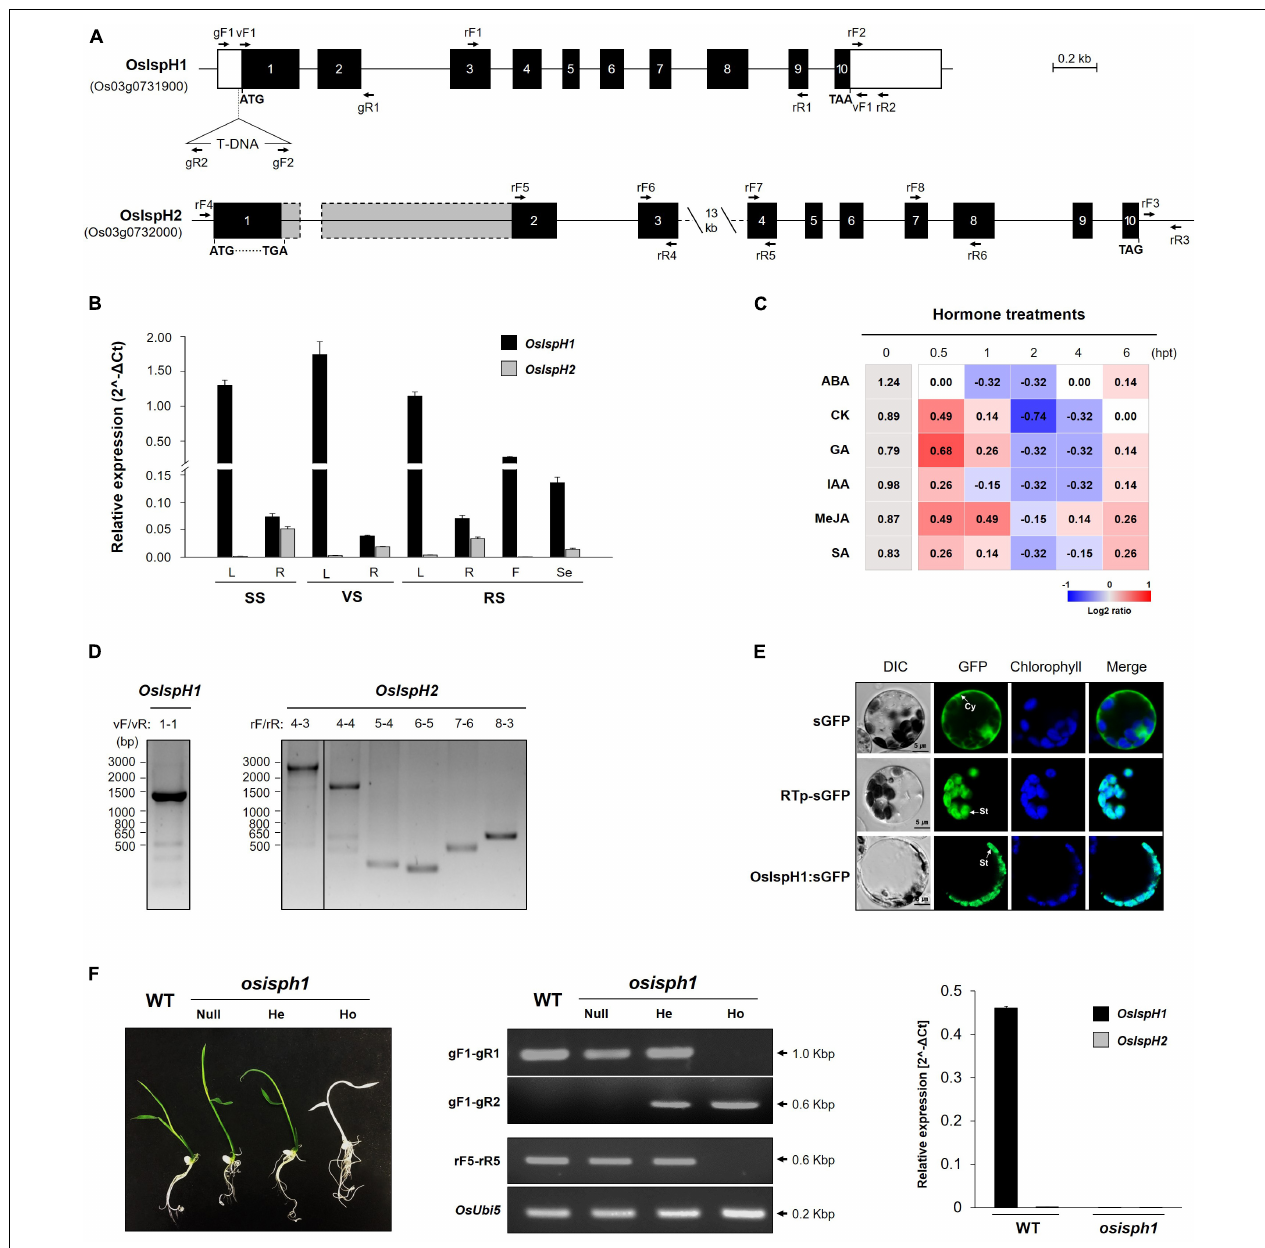
FIGURE 2 | Molecular characterization of rice IspH genes. (A) Genomic structures of the OsIspH1 and OsIspH2 genes and verification of T-DNA position in knockout mutant osisph1 . Solid boxes represent exon (black) and untranslated regions (white); the actual sizes of exons 1 and 2 of OsIspH2 are represented by gray boxes with dotted line, and solid lines indicate introns. Triangle indicates the position of T-DNA insertion. (B) Spatial and temporal expression of OsIspH1 and OsIspH2 in various tissues, including leaves (L), roots (R) of the seedling stage (SS), vegetative stage (VS), and reproductive stage (RS) tissues, and florets (F) of RS and seeds (Se) harvested at 60 days after flowering. (C) Expression profiles of endogenous OsIspH1 in response to different hormone treatments in 10-day-old leaves. The heatmap graph is presented by the relative log2 fold change values of each time point, which were obtained by normalizing the (cid:49) Ct values of each 0 h time point (gray-colored boxes) as individual control, and the (cid:49) Ct value of each 0 h time point is presented in column 0 hpt. (D) Reverse transcriptase PCRs (RT-PCRs) verify the predicted transcript sizes of OsIspH1 (left panel) and OsIspH2 (right panel) using rice young seedling roots. (E) Subcellular localization of the OsIspH1:superfolder green fluorescent protein (sGFP) fusion protein with sGFP and RTp-sGFP, which are used as cytosol (Cy)- and stroma (St)-localized markers, respectively. A confocal microscope was used to detect the sGFP fluorescence and chlorophyll autofluorescence. (F) Characterization of the loss-of-function mutant for OsIspH1 using 5-day-old seedling phenotypes (left panel), genotyping and semiquantitative reverse-transcriptase PCRs (middle panel), and real-time quantitative reverse transcriptase PCR (qRT-PCR, right panel). WT, Oryza sativa Japonica cv. Dongjin as a wild-type control; null, nullizygous plants; He, heterozygous plants; Ho, homozygous plants. The used primer locations are indicated with arrows in (A) and Supplementary Table 10 shows the sequence information. All qRT-PCRs were triplicated and calculated using the (cid:49) Ct equation against the OsUbi5 gene as an internal control. The results are expressed as the mean ± standard error (SE), and Supplementary Tables 3, 4 show the original